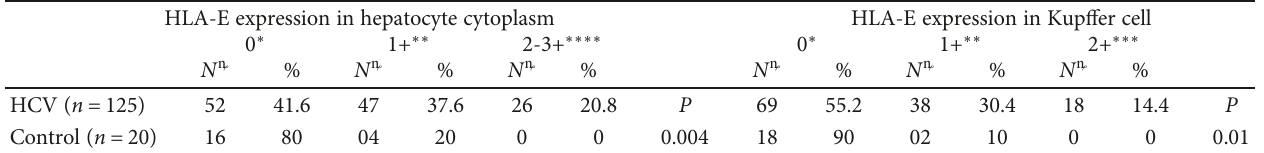
Figure 1: (a) HLA-E positivity in hepatocytes (red arrow) and Kup ff er cells (blue arrow). (b) To analyze the identity of intrahepatic HLA-E- positive cells, liver samples were double-labeled for HLA-E and CD68. All sections were immunostained with the indirect immunoperoxidase method and counterstained with hematoxylin. In double-labeling experiments, we incubated the sections with CD68-speci fi c antibodies after performing the HLA-E-speci fi c immunoperoxidase reaction. A: HLA-E-speci fi c immunoperoxidase reaction (yellow); B: anti-CD68 (red) to con fi rm that these positive cells were Kup ff er cells. Table 1: Frequency of HLA-E expression in hepatocyte cytoplasm and Kup ff er cell in HCV patients and control subjects. HLA-E expression in hepatocyte